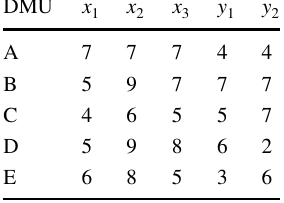
Table 3 Example